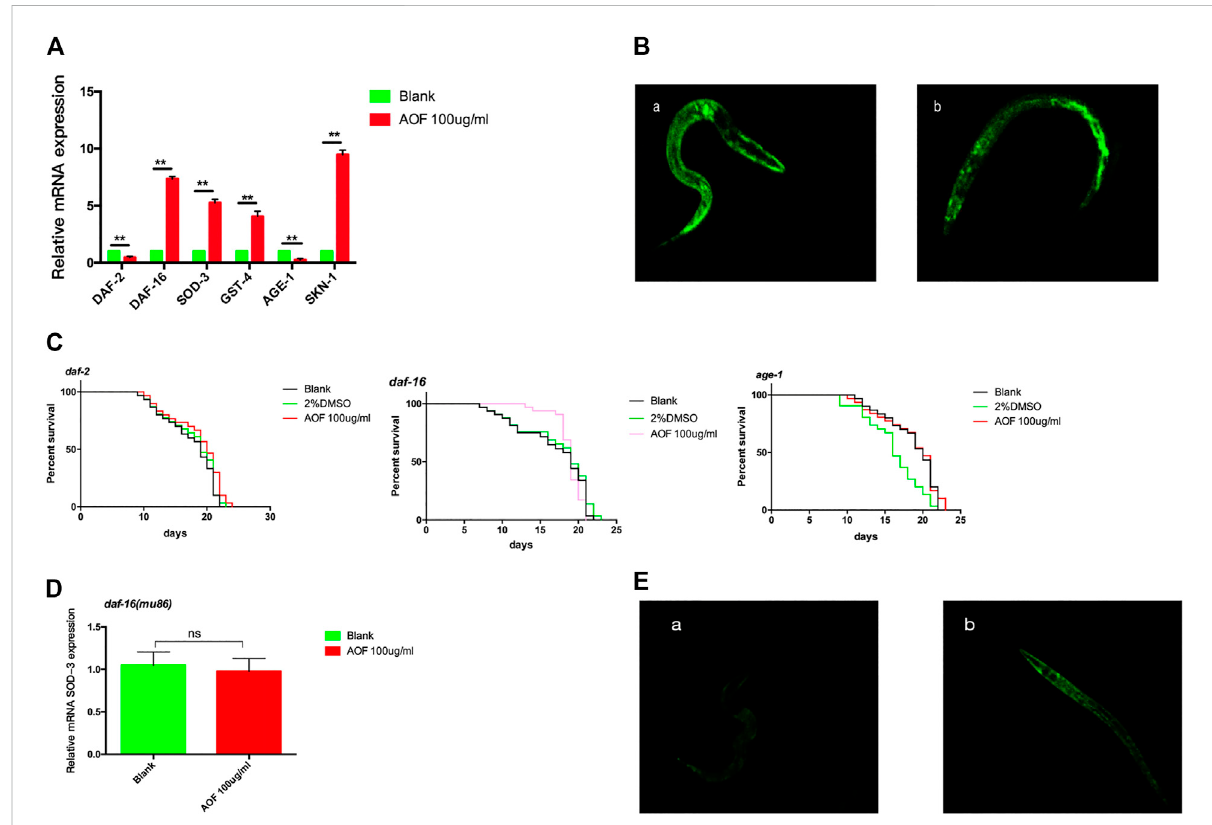
FIGURE 9 The role of the DAF-2-DAF-16 signaling pathway in the anti-aging effects of AOF. (A) Relative expression of aging-related genes in (C) elegans . (B) A representative image of DAF-16:GFP expression in (A) , control group and (B) , 100 μ g/ml AOF group. (C) Effect of AOF on the lifespan of daf-2, daf-16,orage-1mutantworms. (D) TherelativeSOD-3mRNAexpressionindaf-16mutants. (E) Fluorescenceintensityofsod-3:GFPafterAOFin (A) , control group and (B) , 100 μ g/ml AOF group.Data are the mean ± SD (n = 3). **p < 0.01